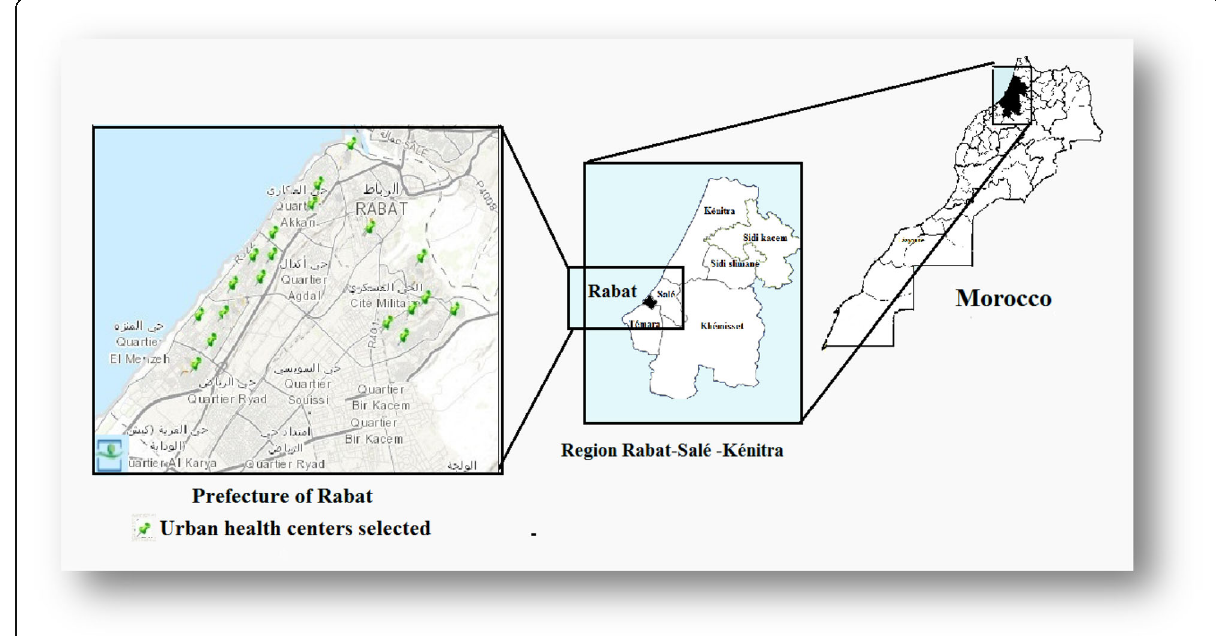
Fig. 1 Map of Morocco, region of Rabat-Salé-Kénitra, prefecture of Rabat with urban health centers